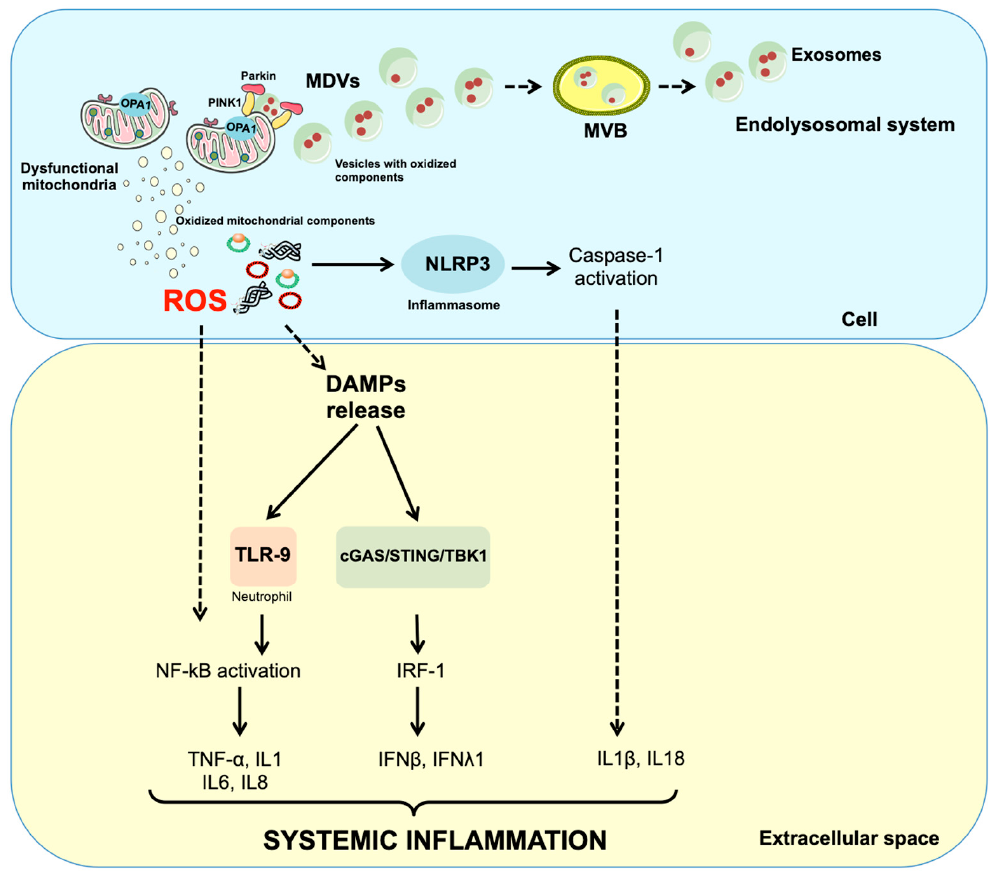
Figure 2. Schematic representation of possible mechanisms releasing mitochondrial components into the circulation. Dysfunctional but not yet depolarised mitochondria are targeted to degradation by serine/threonine-protein kinase PTEN-induced putative kinase 1 (PINK1) and Parkin. This priming process may also assist in the generation of mitochondrial-derived vesicles (MDVs). MDVs reach out the endolysosomal system and form multivesicular bodies (MVBs) that are unloaded outside the cell as exosomes. Impairment of mitochondrial quality control processes may also lead to accumulation of intracellular oxidised components that can be released as damage-associated molecular patterns (DAMPs) following a vesicle-free pathway. In particular, damaged mitochondrial transcription factor A (TFAM)-bound (green circles) or unbound (red circles) mitochondrial DNA (mtDNA) particles can be released as DAMPs. These molecules are pro-inflammatory and can activate three distinct signalling routes via interaction with (1) toll-like receptors (TLRs), (2) nucleotide-binding oligomerisation domain (NOD)-like receptor family pyrin domain containing 3 (NLRP3) inflammasome and (3) cytosolic cyclic GMP-AMP synthase (cGAS)-stimulator of interferon genes (STING) DNA-sensing system. IFN, interferon; IL, interleukin; IRF-1, interferon regulatory factor 1; NF- κ B, nuclear factor κ B; OPA1, optic atrophy 1; ROS, reactive oxygen species; TBK1, TANK-binding kinase 1; TNF- α , tumour necrosis factor alpha.